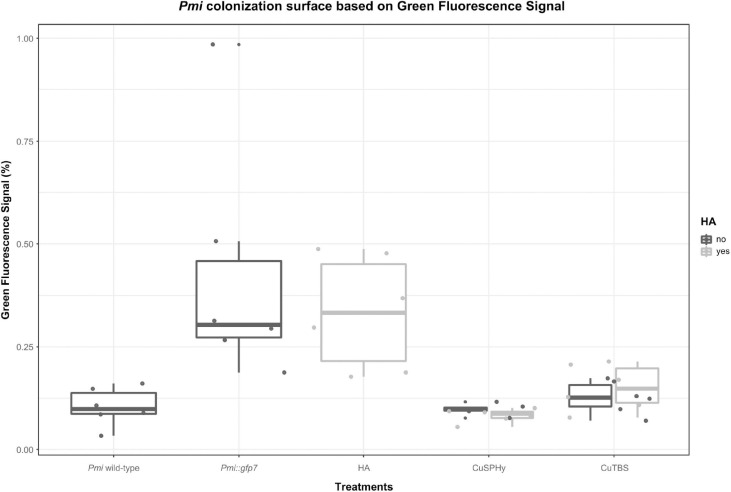
Estimation of the Pmi::gfp7 colonization based on the overall fluorescent surface spotted in the CLSM images (four repetitions per six technical replicates) processed by Image J software 1.47v. Boxplots show the % of green fluorescence signal in control and treated plant samples. Pmi wild-type strain represents the negative control, and Pmi::gfp7 represents the positive control reference. Boxplots were arranged by treatments (controls and formulations) and HA (absent, present). A supplementary statistical analysis is reported in Supplementary Table 3.